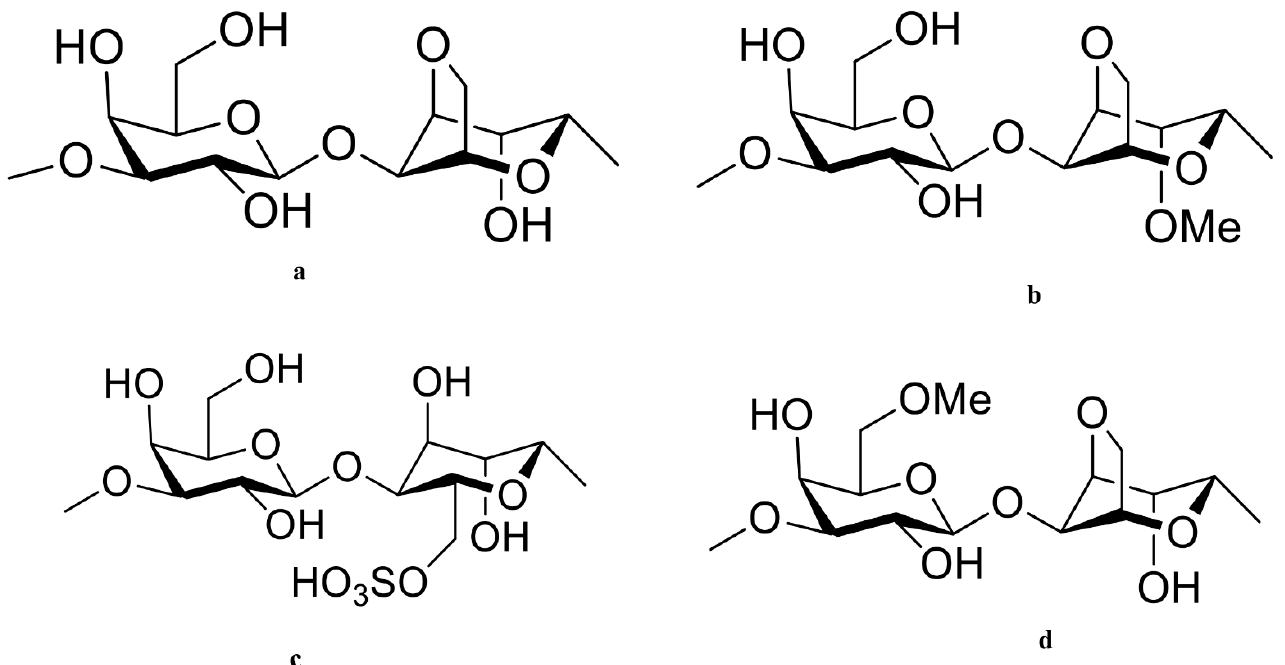
Figure 4. The Molecular structure of different types of porphyran with potential therapeutic effects are drawn in Chemdraw 12.0 Ultra. The Polymeric structures of porphyran such as G-A ( a ); G-A2M ( b ); G-L6S ( c ); and G6M-A ( d ).